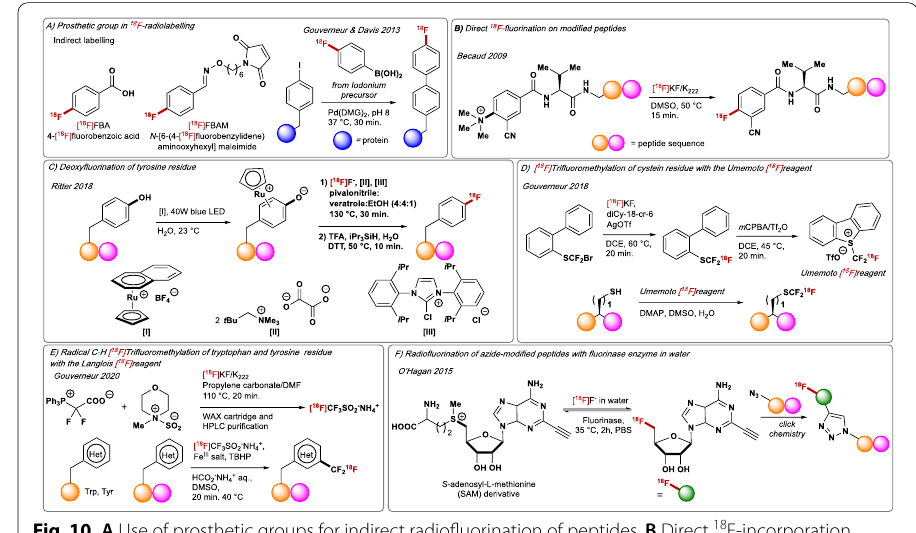
Fig. 10 A Use of prosthetic groups for indirect radiofluorination of peptides. B Direct 18 F-incorporation on modified peptides. C Ru-mediated deoxyfluorination of peptidic tyrosine. D [ 18 F]Umemoto reagent for radiofluorination of peptidic cysteine. E C–H 18 F-Trifluoromethylation of peptidic tryptophan and tyrosine with the [ 18 F]Langlois reagent. F Radiofluorination with fluorinase enzyme. DMG TFA trifluoroacetic acid. DTT = =